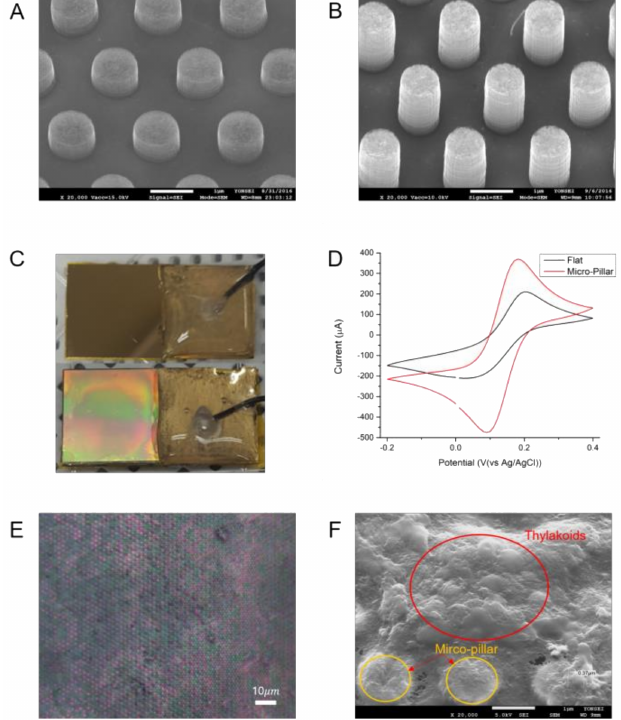
Figure 4. SEM image of MP electrodes with aspect ratio of ( A ) 1.0 (MACE1) and ( B ) 1.5 (MACE2); ( C ) Au-coated flat (above) and MP (below) electrodes; ( D ) Cyclic voltammetry to determine the electrochemical surface of a flat and MP electrode using a solution of 10 mM potassium ferricyanide and 100 mM potassium nitrate. The potential range was − 0.2 V to 0.4 V and the scan rate was 20 mV/s; ( E ) Optical microscope image of thylakoids on MP electrodes; ( F ) SEM image of thylakoids on MP